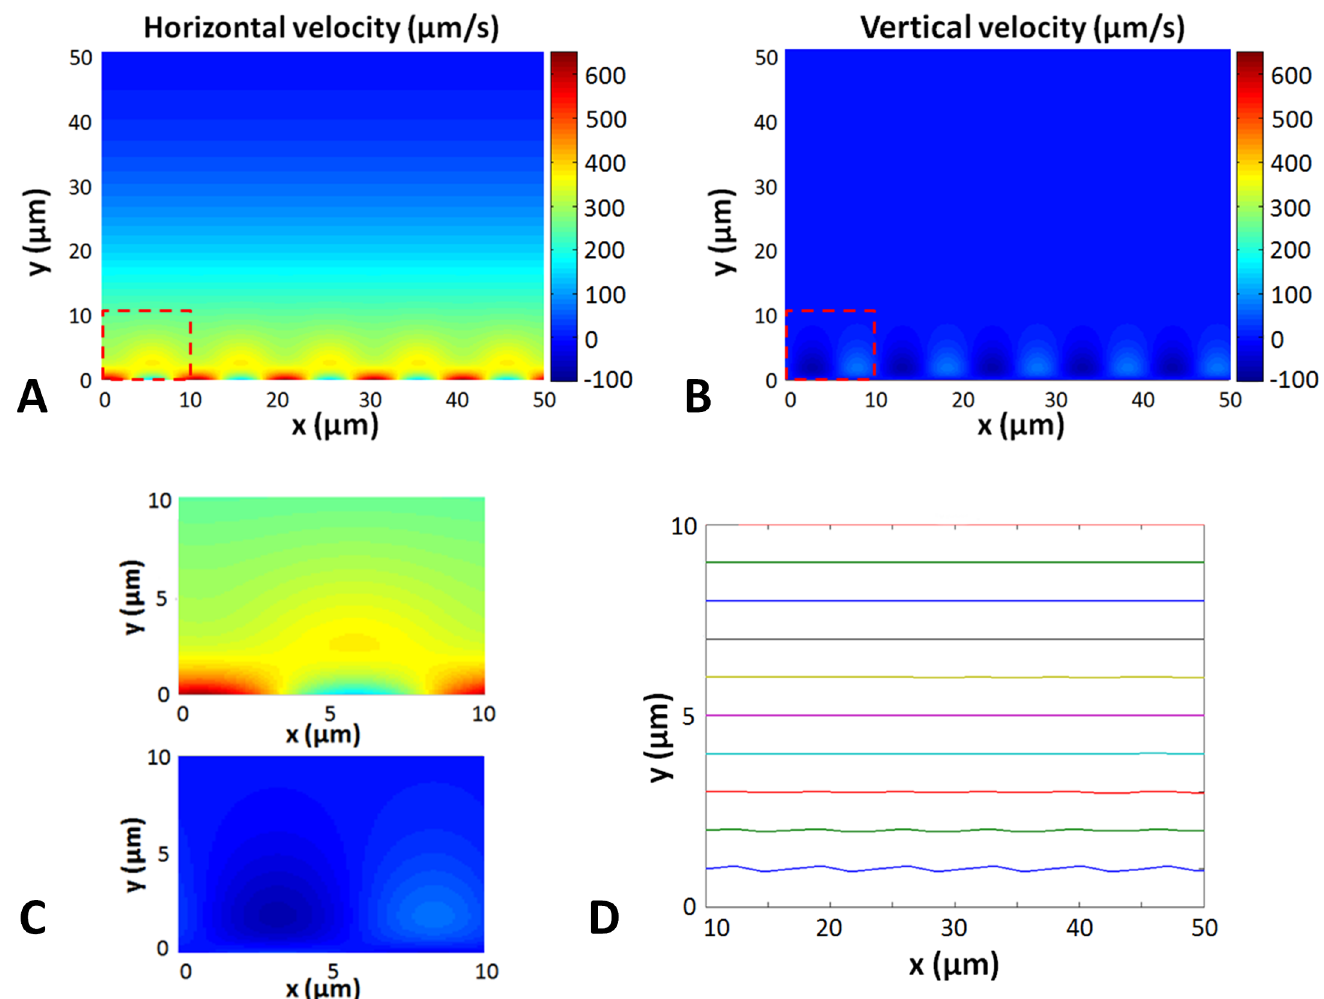
Fig 3. Numerical simulation of the velocity field and micro-bead trajectories. (A) Color view of the horizontalvelocity field. The dashed square representsthe zoomed-in area represented in Fig 3C. The beatingparameters are: CBF = 10 Hz, CBA = 8 μ m, λ = 10 μ m, Φ = 0, h = 50 μ m). (B) Color view of the vertical velocity field. The dashedsquare represents the zoomed-in area representedin Fig 3C. (C) Zoomed in horizontal (top frame) and vertical (bottom frame) velocity field. (D) Particle trajectories for several insertion points. The particles enter the fluid flow on the left side of the window and travel to the